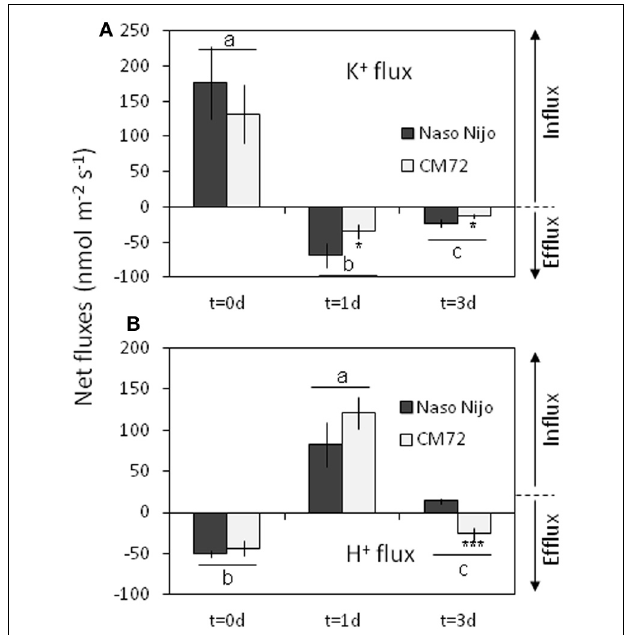
FIGURE 13 | Net steady-state K + (A) and H + (B) fluxes measured from mature barley root epidermis in control (day 0) and after one and three days exposure to 1mM Mn. Mean ± SD ( n = 6). Different lower case letters indicate the significant difference between treatments (averaged for both genotypes) at P < 0 . 05. Asterisks indicate the significant difference between cultivars within treatment at ∗ P < 0 . 05 and ∗∗∗ P < 0 .